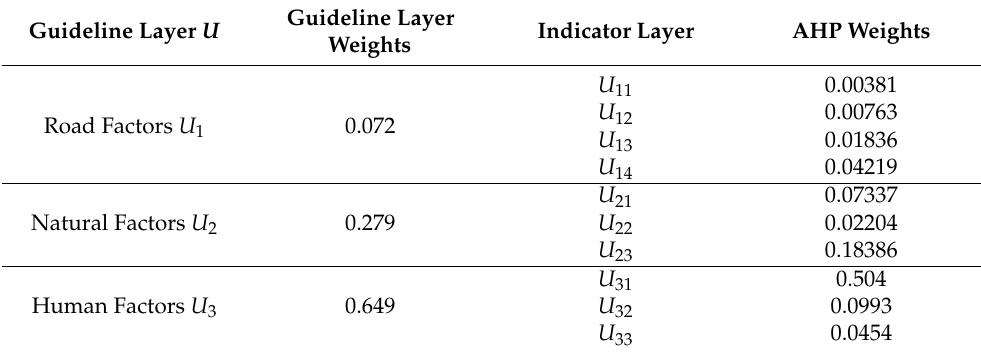
Table 9. The weighting of road traffic trend indicators for the AHP